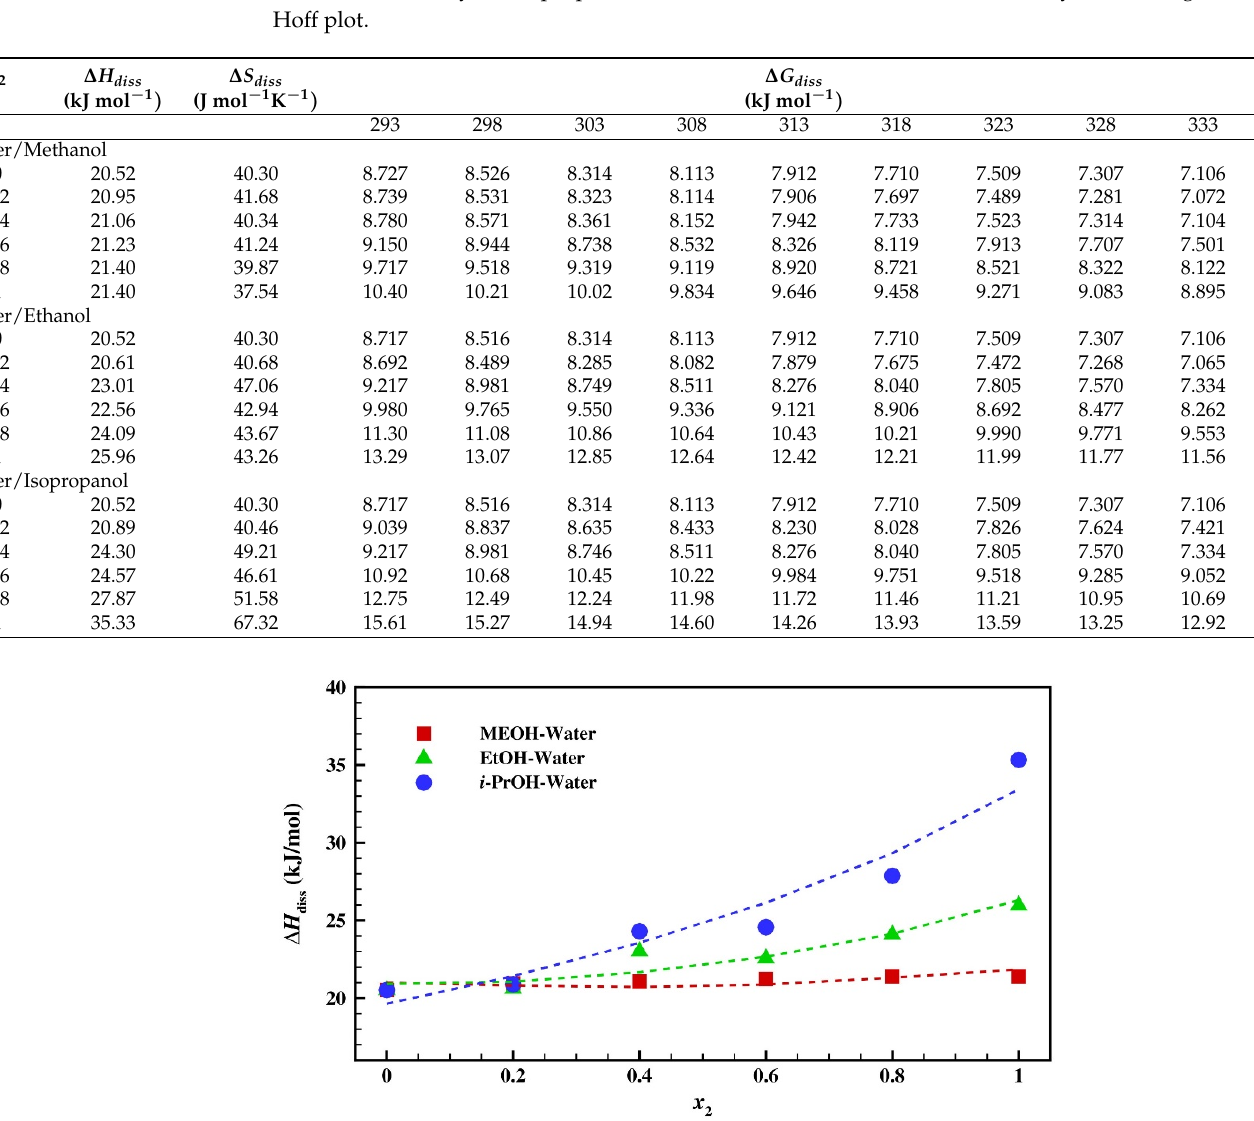
Figure 7. Change in dissolution enthalpy with alcohol composition in binary solvent systems. Symbols: Enthalpy using Van’t Hoff (Equation (11)); Dotted lined: Enthalpy using Jouyban-Acree model (Equation